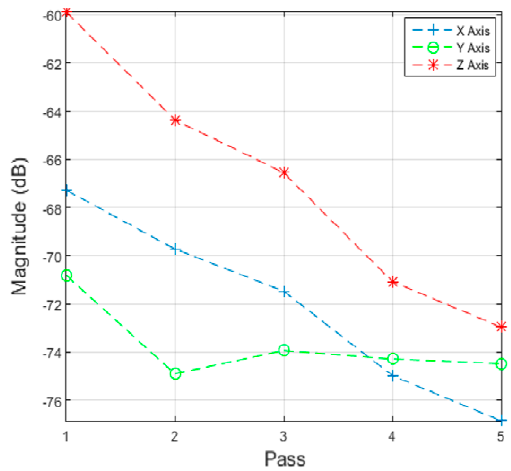
Figure 16. Signal magnitude vs. number of passes/cycle.